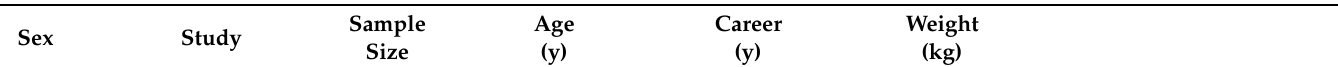
muscular power (standing long jump); cardiorespiratory endurance (20-m MST); flexibility (sit and reach); isokinetic muscular strength (left knee joint flexion at 60 ◦ /s, left knee joint extension at 60 ◦ /s, right knee joint flexion at 60 ◦ /s, right knee joint extension at 60 ◦ /s, left knee joint flexion at 120 ◦ /s, left knee joint extension at 120 ◦ /s, right knee joint flexion at 120 ◦ /s, right knee joint extension at 120 ◦ /s, left knee joint flexion at 240 ◦ /s, left knee joint extension at 240 ◦ /s, right knee joint flexion at 240 ◦ /s, right knee joint extension at 240 ◦ /s, left hip joint flexion at 30 ◦ /s, left hip joint extension at 30 ◦ /s, right hip joint flexion at 30 ◦ /s, right hip joint extension at 30 ◦ /s, left hip joint flexion at 60 ◦ /s, left hip joint extension at 60 ◦ /s, right hip joint flexion at 60 ◦ /s, right hip joint extension at 60 ◦ /s, trunk joint flexion at 60 ◦ /s, trunk joint extension at 60 ◦ /s, trunk joint flexion at 120 ◦ /s, and trunk joint extension at 120 ◦ /s)